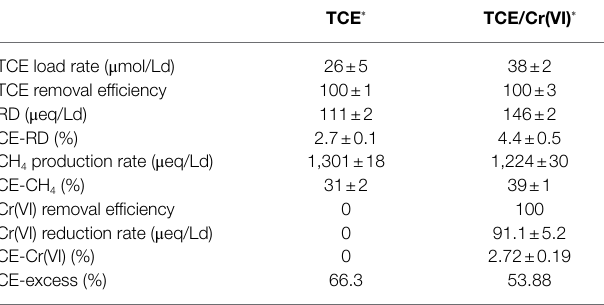
TABLE 1 | Reductive dechlorination and methanogenesis performances during TCE and TCE/Cr(VI) operating